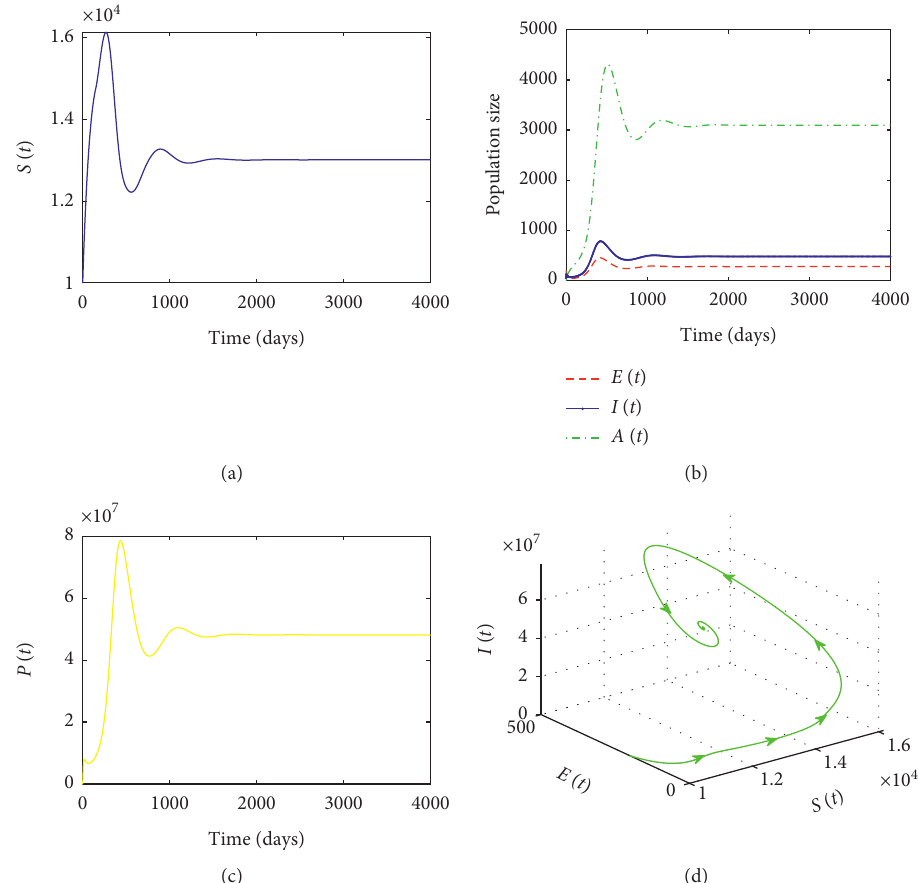
Figure 3: Numerical results of system (1) depicting the persistence of the disease of R Parameter values used to construct the simulations are in Table 1, with p � 0 . 01 and κ � ϵ � 0, leading to R